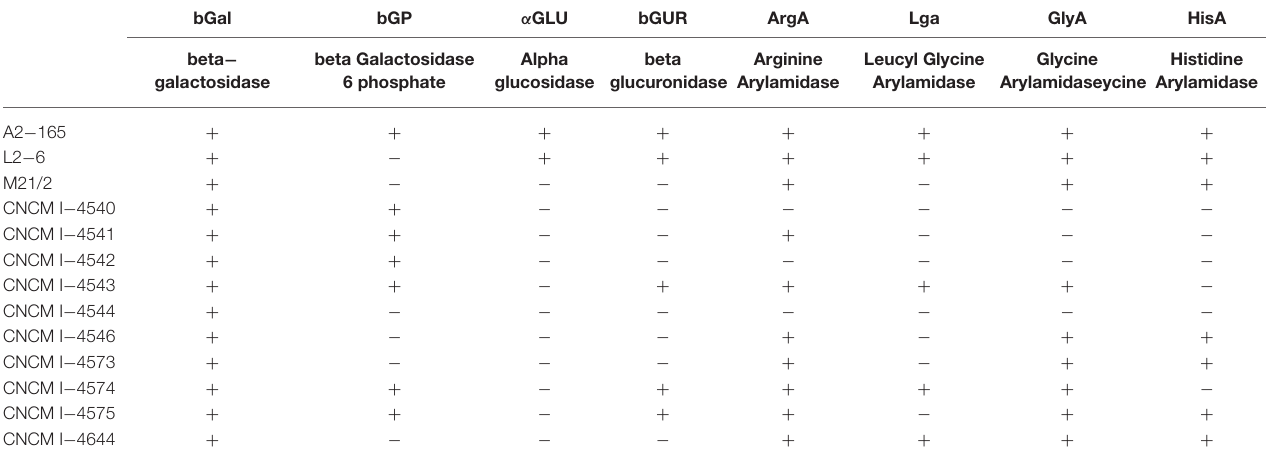
TABLE 4 | Metabolic capacities of F. prausnitzii strains detected by API 32A galleries. bGal bGP α GLU bGUR